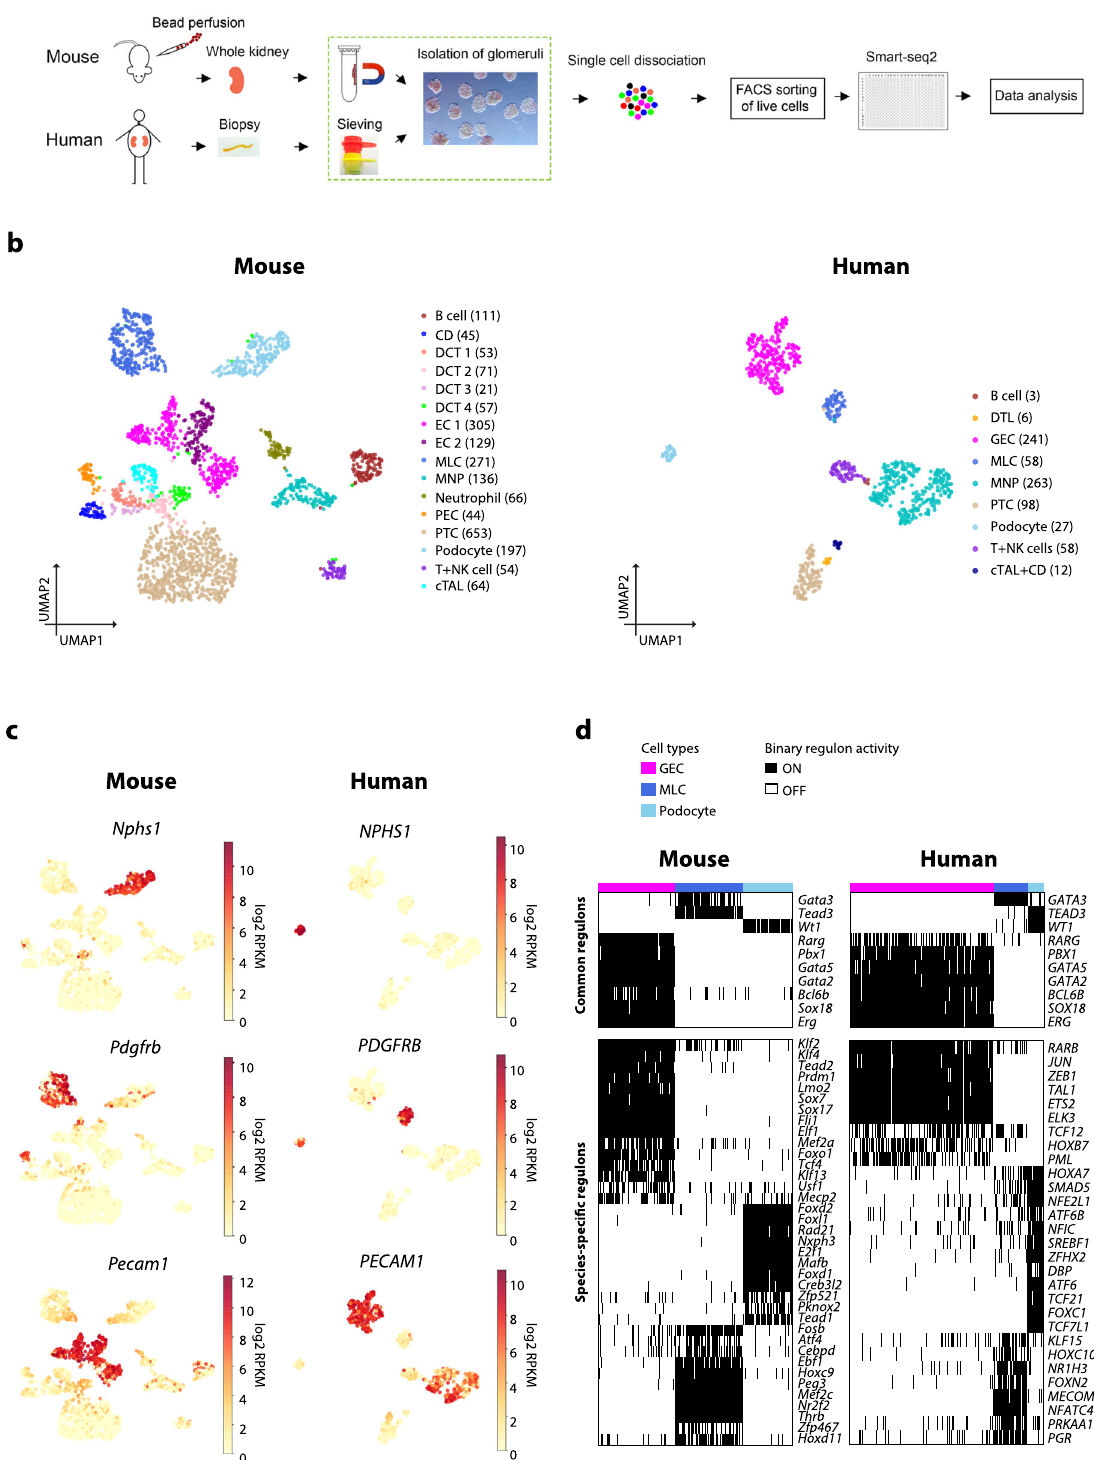
Supplementary Data 4). MLC-C2 and MLC-C3 showed high expression of vSMC markers, such as Cnn1 and Acta2 , and MLC- C3 was also strongly expressing Ren1 (Supplementary Data 4 and 5). Thus, MLC-C2 and MLC-C3 represented a mixture of vSMCs and renin-producing cells, originating most likely from glomerulus-associated afferent/efferent